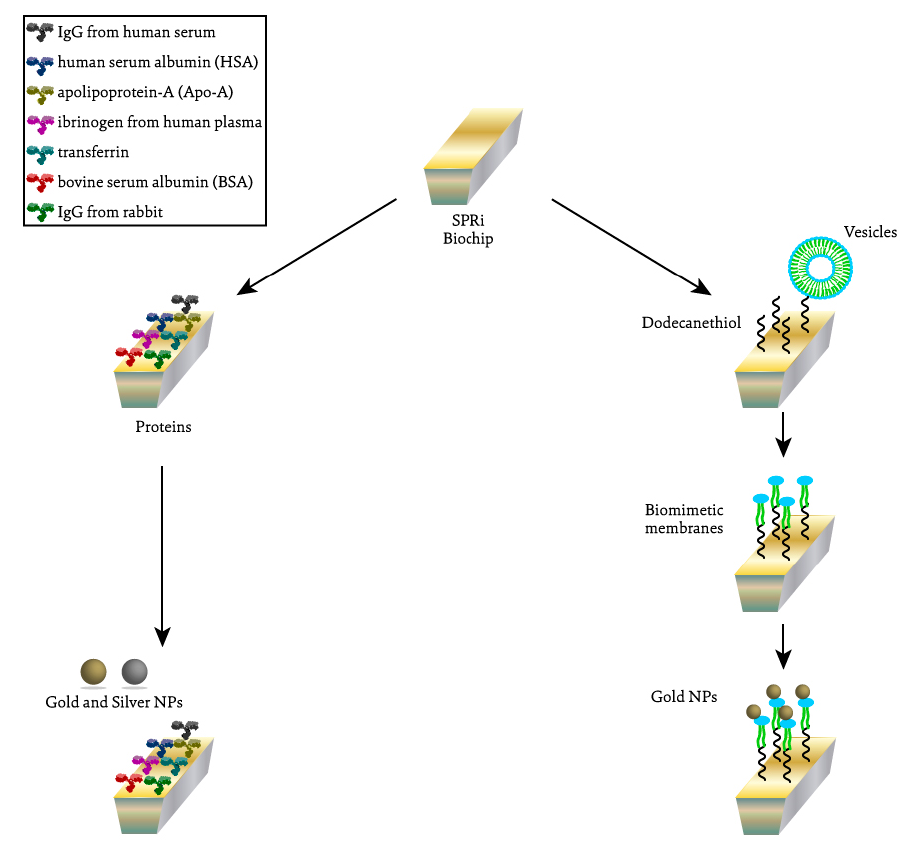
Figure 1. Schematic representation of the different SPRi assays performed to evaluate the interaction between silver and gold NPs and proteins ( on the left ) and between gold NPs and lipidic membranes ( on the right ).